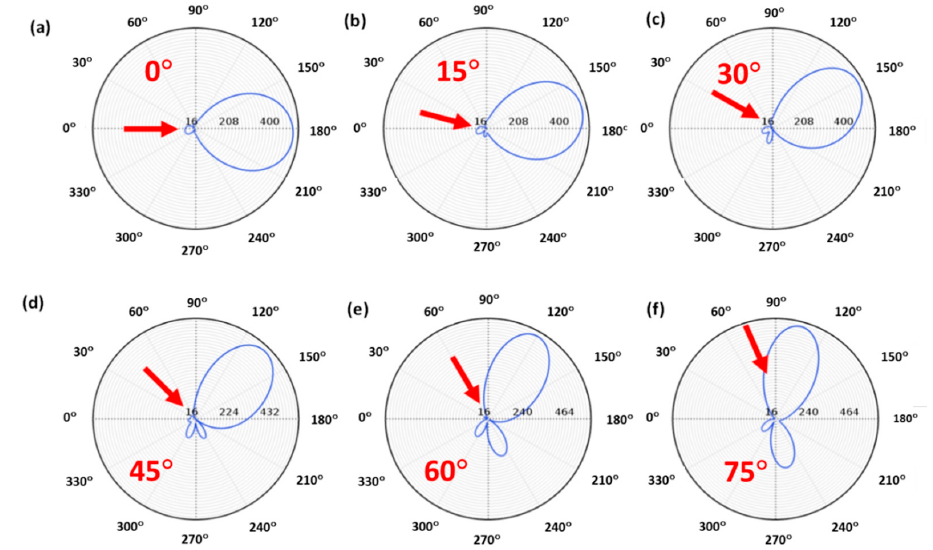
Figure 4. The far field polar plot of a 184 nm Cu 2 O particle, satisfying the zero-backward scattering condition, on a glass substrate and considering different incident angles with respect to the substrate: from 0° to 75° ( a )–( f ). The considered wavelength was 632 nm. Red arrows indicate the direction of the impinging light.